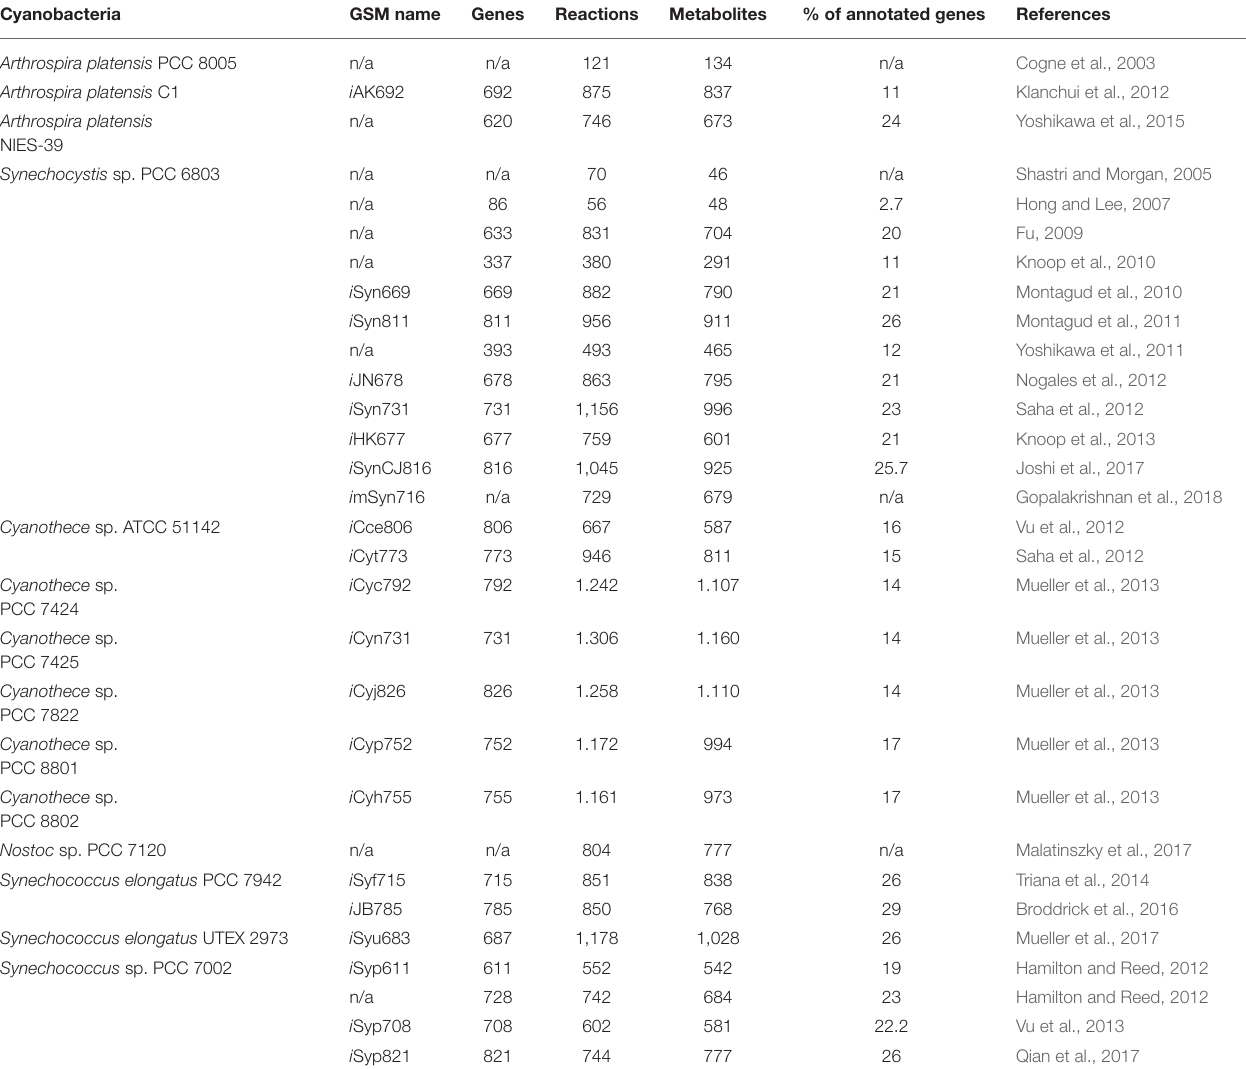
TABLE 2 | GSMs described for cyanobacterial strains.